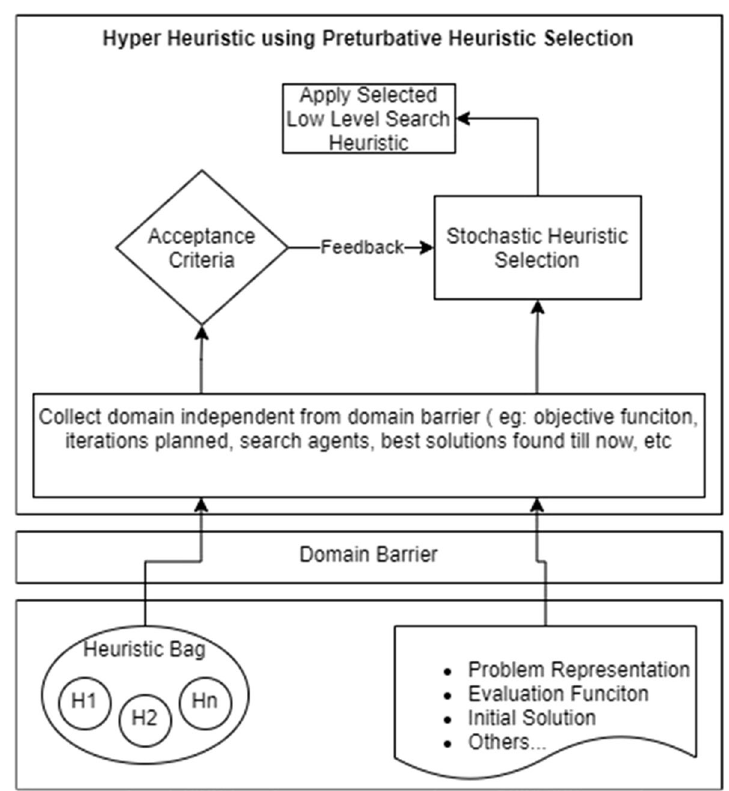
Fig. 3 Hyper-heuristic using perturbative heuristic